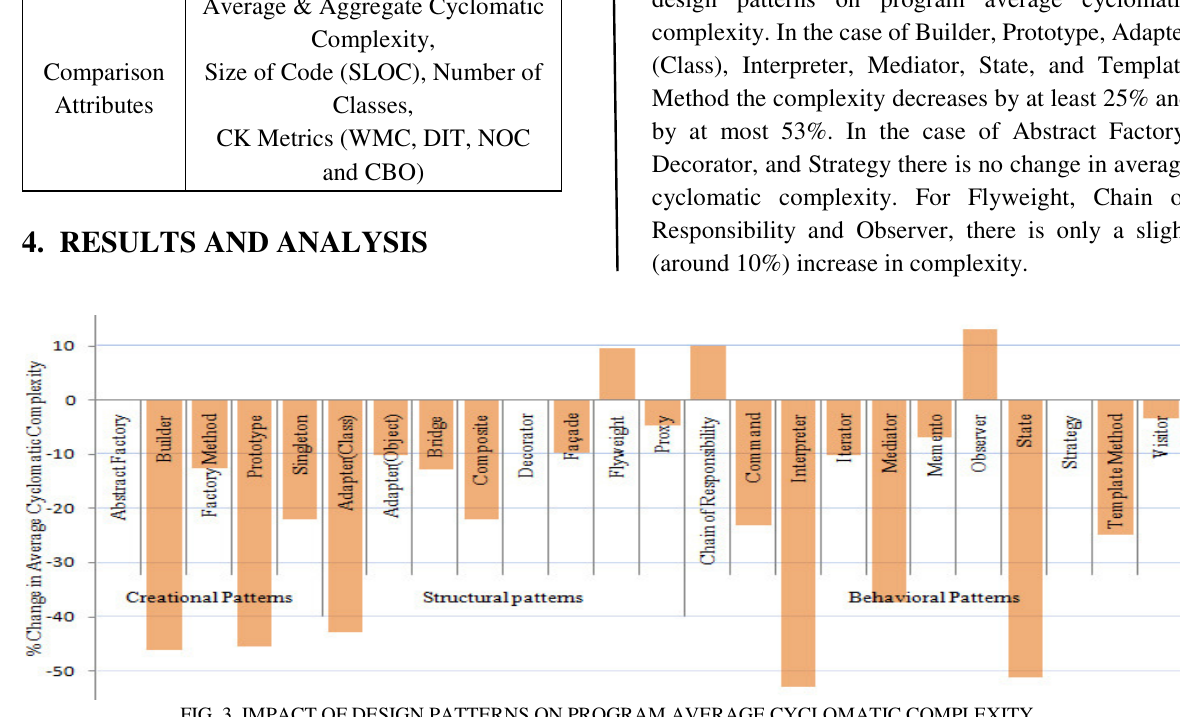
FIG. 3. IMPACT OF DESIGN PATTERNS ON PROGRAM AVERAGE CYCLOMATIC